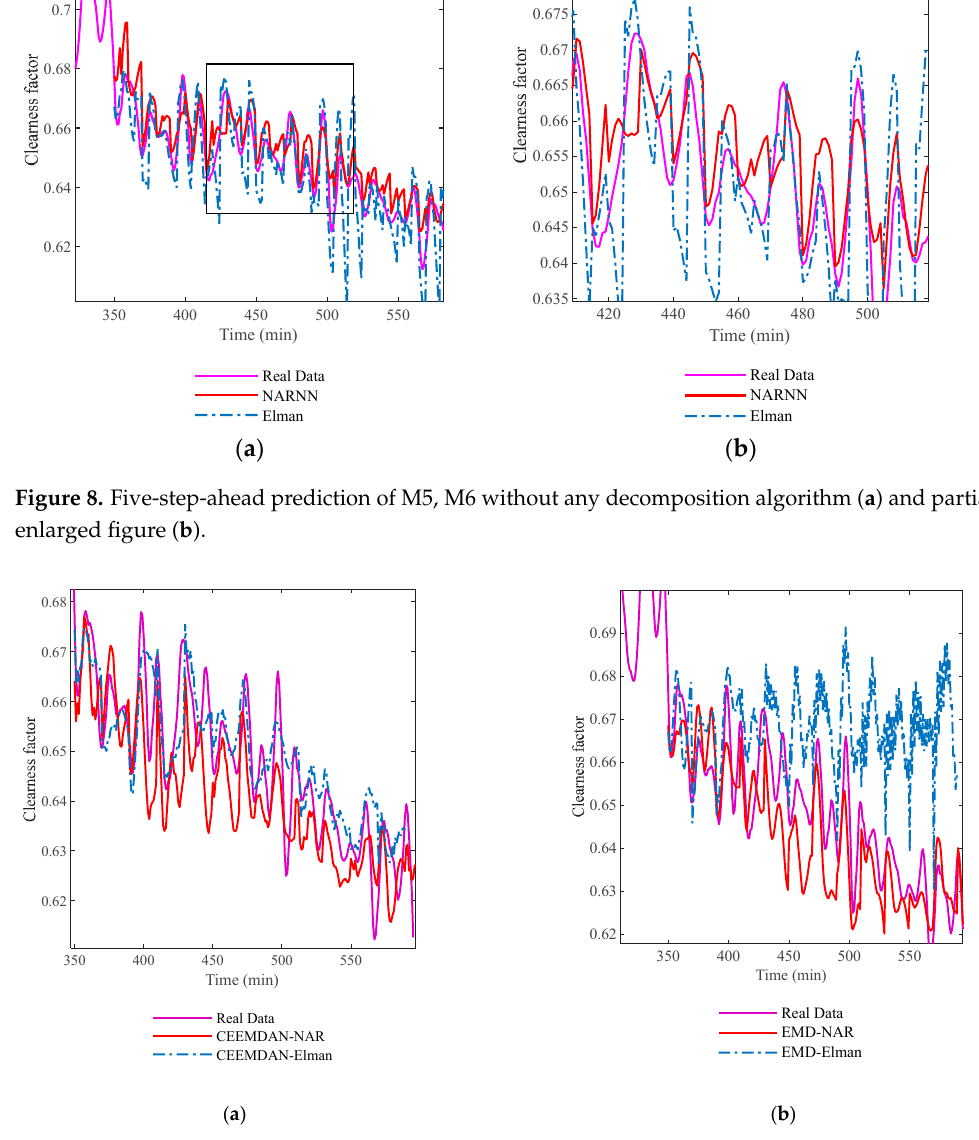
Figure 9. Twenty ‐ step ‐ ahead prediction of M1, M3 and M2, M4 using CEEMDAN ( a ) and EMD ( b ). Figure 9. Twenty-step-ahead prediction of M1, M3 and M2, M4 using CEEMDAN ( a ) and EMD ( b